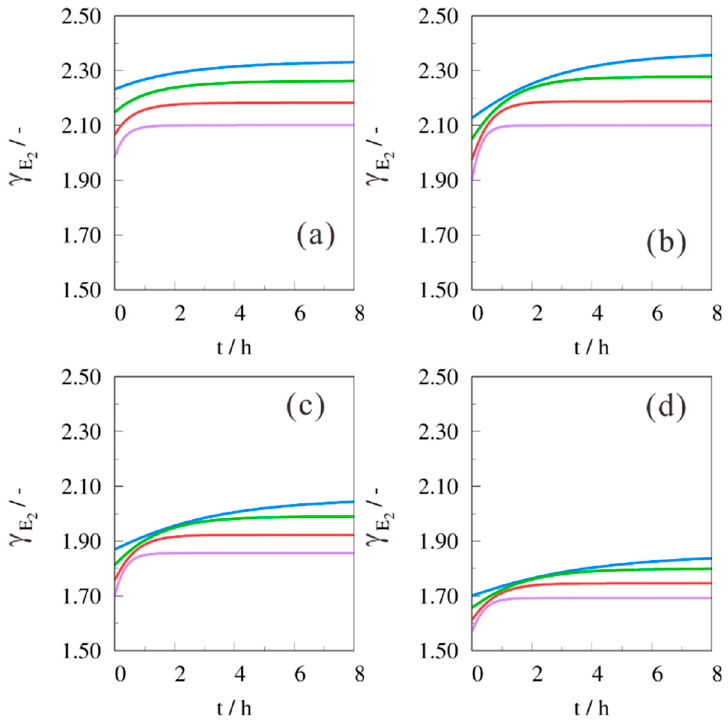
Figure 5. Activity coe ffi cient for E 2 versus reaction time with ( B / H ) 0 = 2 mol · mol − 1 . Solvent = ( a ) methanol; ( b ) ethanol; ( c ) n-propanol; ( d ) n-butanol; T = ( ─ ) 80 °C, ( ─ ) 100 °C, ( ─ ) 120 °C, ( ─ ) 140 °C.